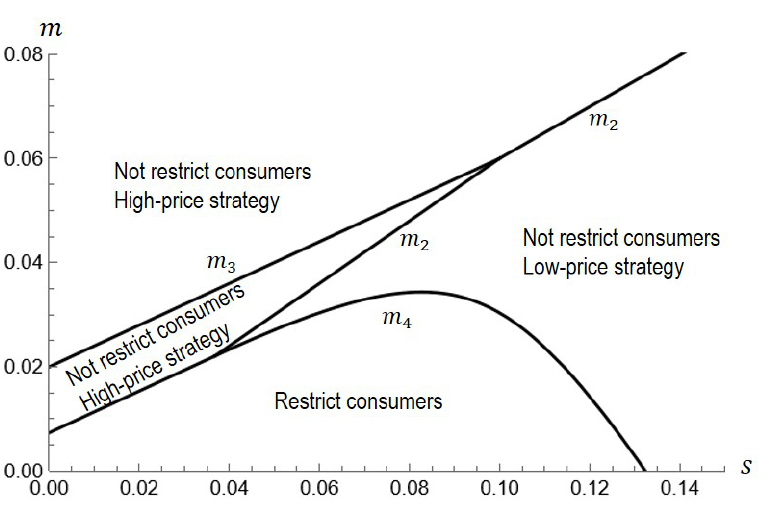
Figure 6. Seller’s pricing strategy in scenario RR ( c = 0.4, θ = 0.6, λ l = 0.4, λ h = 0.6, β = 2, h = 0.1, k =